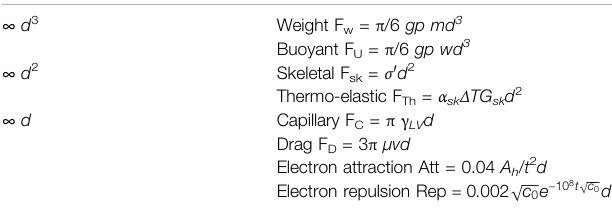
TABLE 3 | Particle-level forces. They scale with d, d 2+ , and d 3 . The ratio between the skeletal force and all other forces con fi rms the importance of the particle buoyant weight in coarse-grained sediments and of capillary, drag, and electrical forces on phenomena that take place in fi ne-grained sediments (Mitchell, 1976; Santamarina,